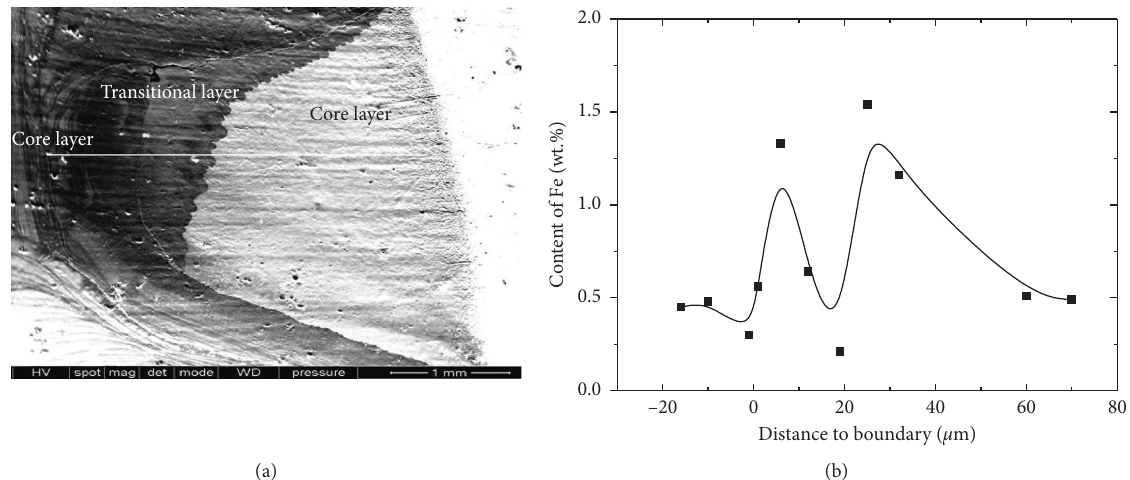
Figure 3: Hardness near the grain boundary of the abnormal grain. (a) Micrograph of the grain boundary. (b) Hardness across the grain boundary of the abnormal